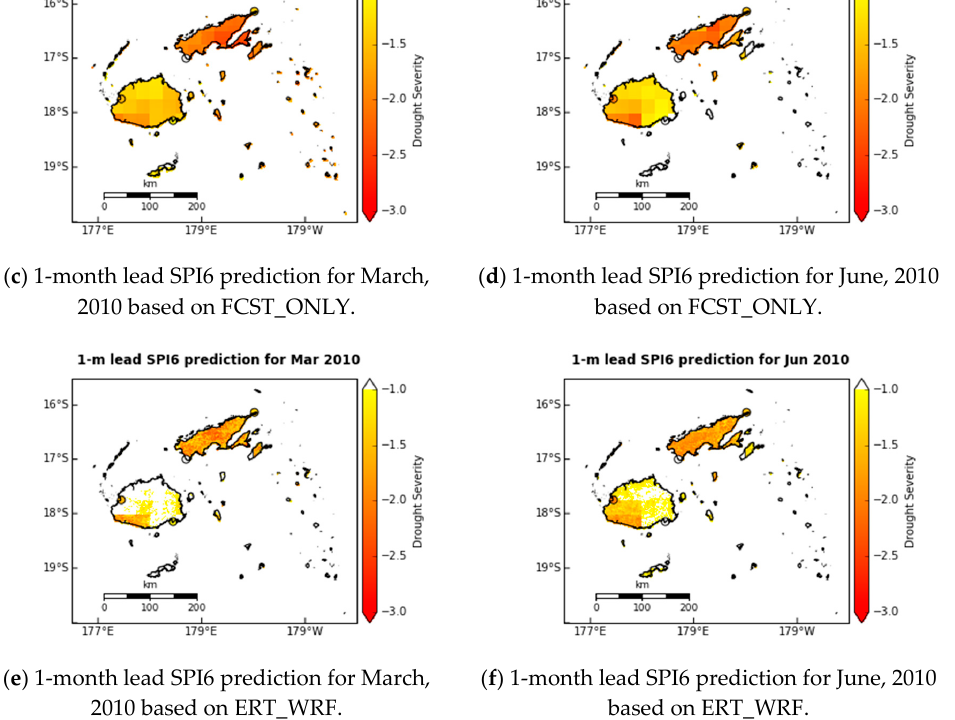
Figure 9. Spatial distribution maps of 1-month lead SPI6 predictions for March 2010 and June 2010 and WRF-based SPI6.